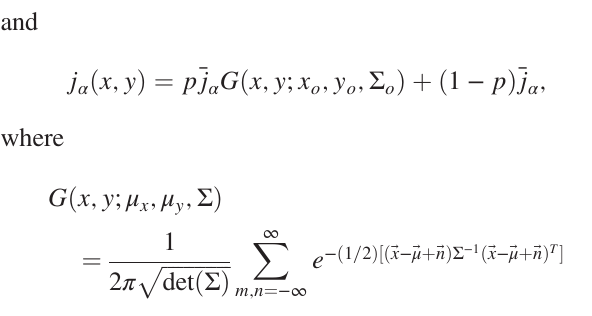
balanced fixed point does not exist. (d) Same as (a) except σ 0 . 02 . Open video file in a web browser to view e ¼